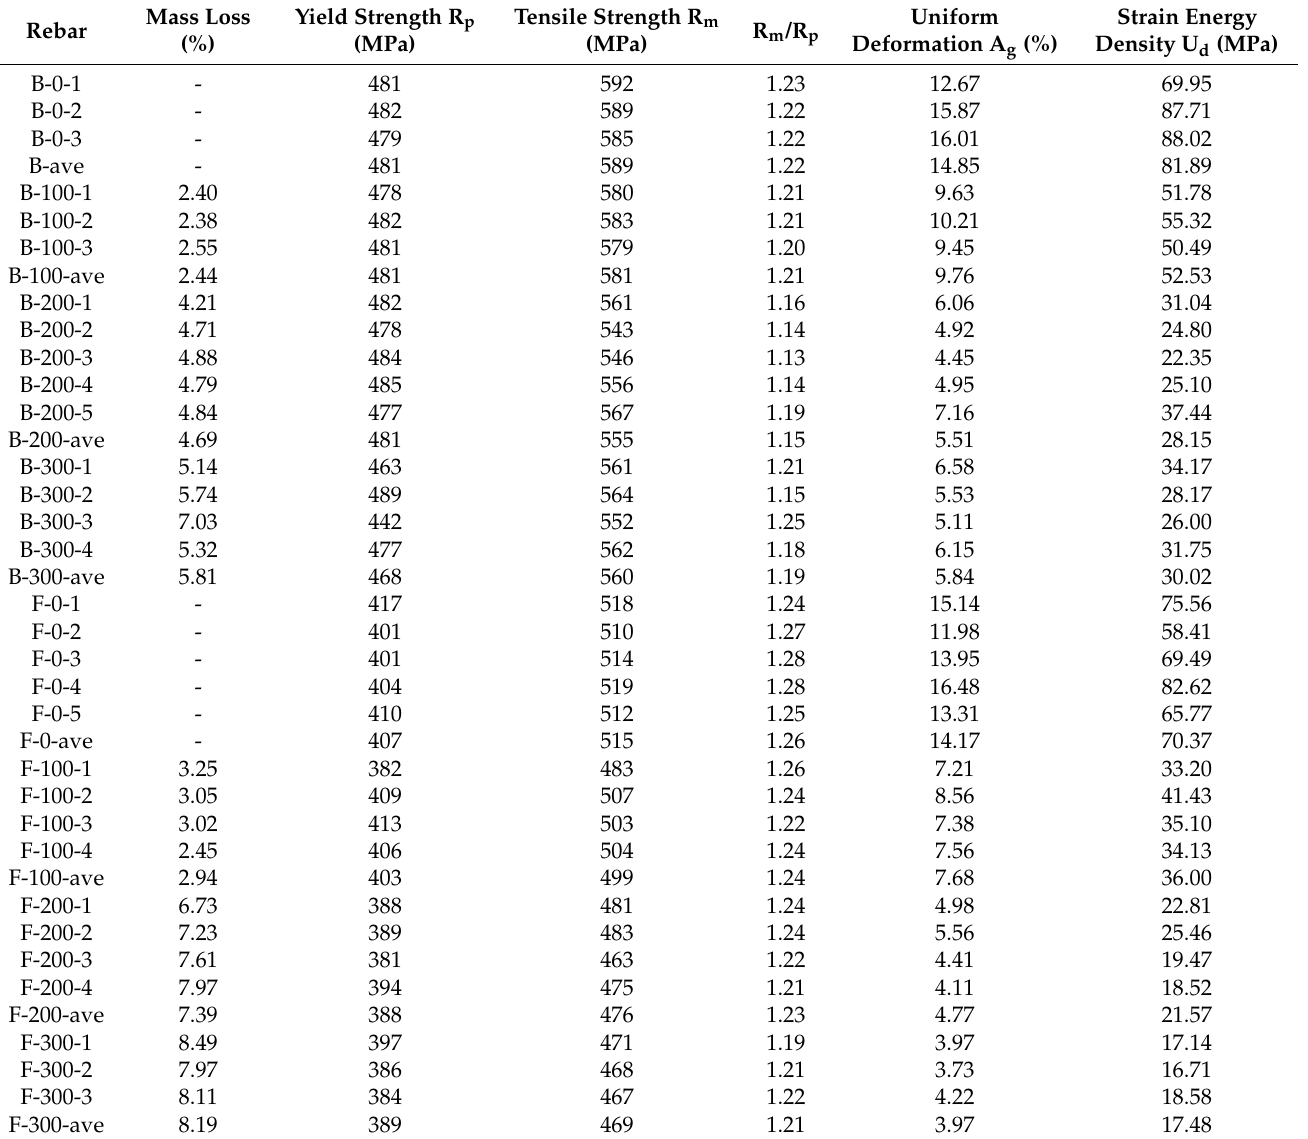
Table 5. Results of tensile tests on Tempcore B and Dual Phase F (DPF) rebars (non-corroded and corroded